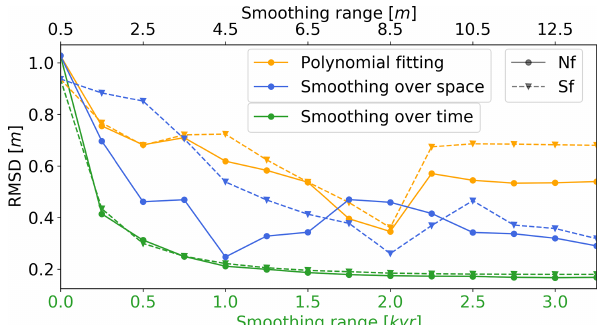
Figure 2. Smoothing techniques to find the best resolutions of DEM for curvature. For the smoothing over time approach, the time step is 1 year; the diffusion coefficient, K d , is 11 × 10 − 3 m 2 /yr and 18 × 10 − 3 for the north-facing and south-facing hillslopes, respec- tively. Nf stands for north-facing hillslope, and Sf stands for south- facing hillslope.